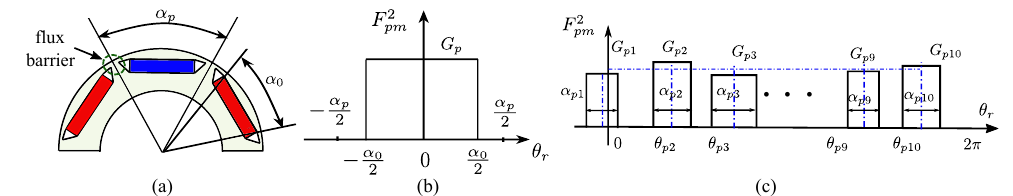
Figure 1. The equivalent PM excited MMF distribution for an IPM machine. ( a ) The schematic diagram of the IPM rotor; ( b ) the equivalent F 2 pm excited by one PM within one pole-pitch; ( c ) The equivalent MMF along the rotor considering manufacturing uncertainties for a 12S10P machine, where G pi and α pi corresponds to the magnitude and width of the i th equivalent rectangle